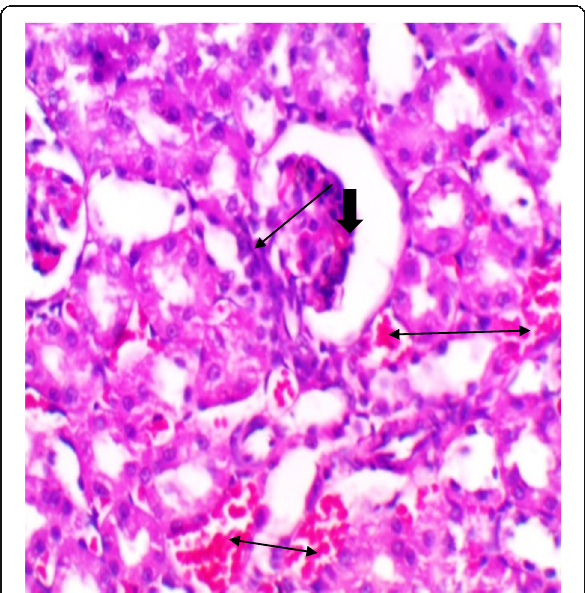
Fig. 14 Photomicrograph of CCl4-treated kidney sections showing sever congestion (2head arrow), vacuolation, inflammatory changes (arrow) and dilatation of Bowman ’ s space with glomerular atrophy